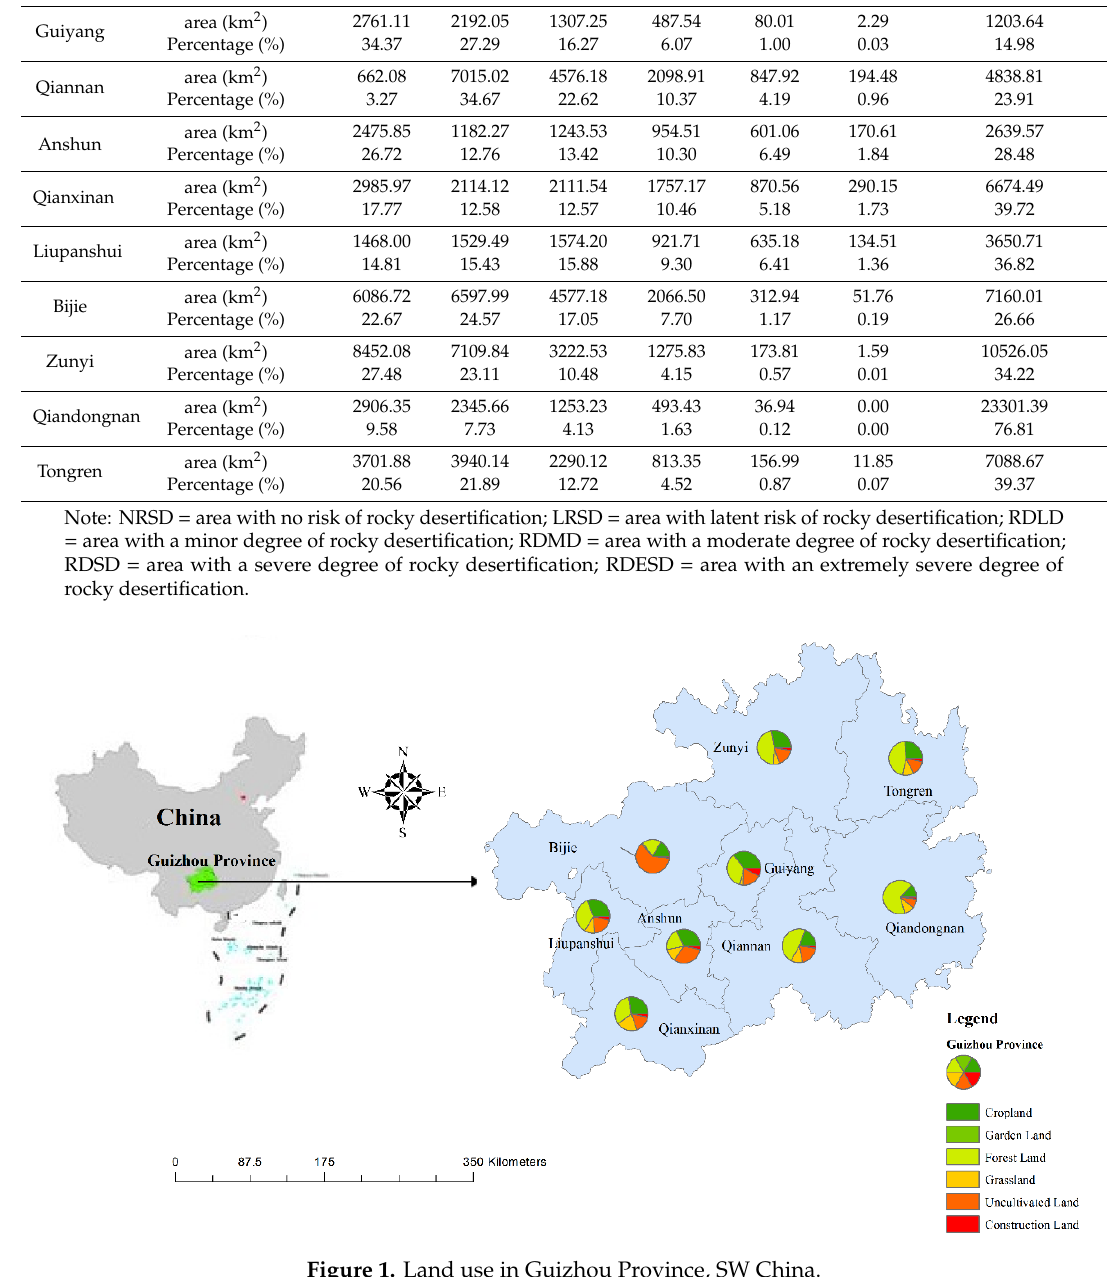
Figure 1. Land use in Guizhou Province, SW China.